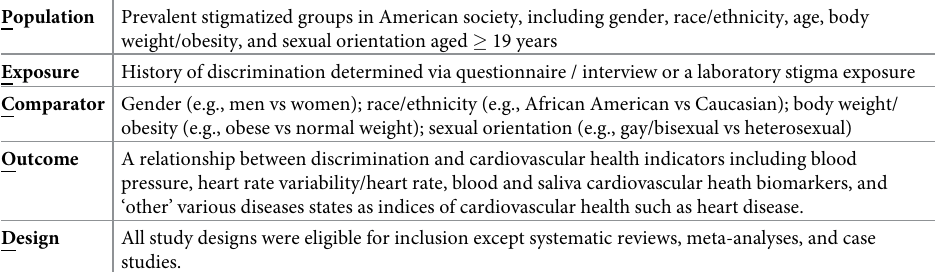
‘other’ various diseases states as indices of cardiovascular health such as heart